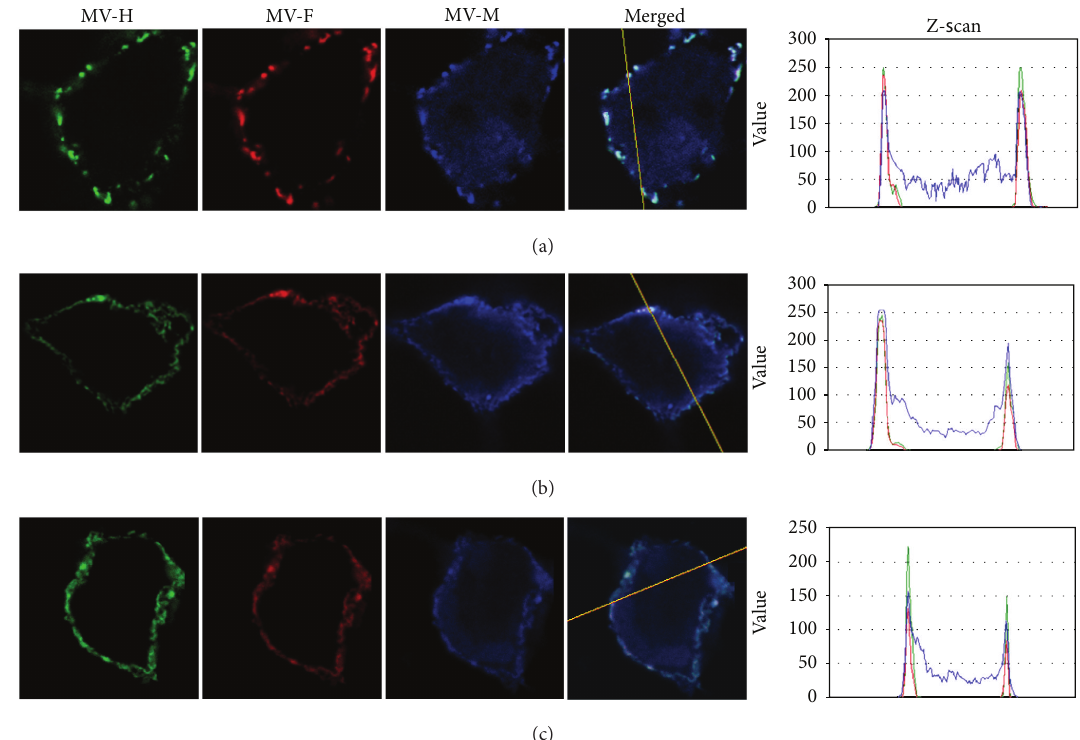
Figure 8: Confocal study of localization of H, F, and M proteins of escape mutants Halle-CD46 3.3 and Halle-SLAM 5.1: (a) phCMV.H + phCMV.F + phCMV.M (control); (b) phCMV.H.L136P + phCMV.F + phCMV.M.K243E/S312P; (c) phCMV.H + phCMV.F.I329N + phCMV.M.T172I. The H, F, and M proteins are labeled green, red, and blue, respectively. Magnification × 630.